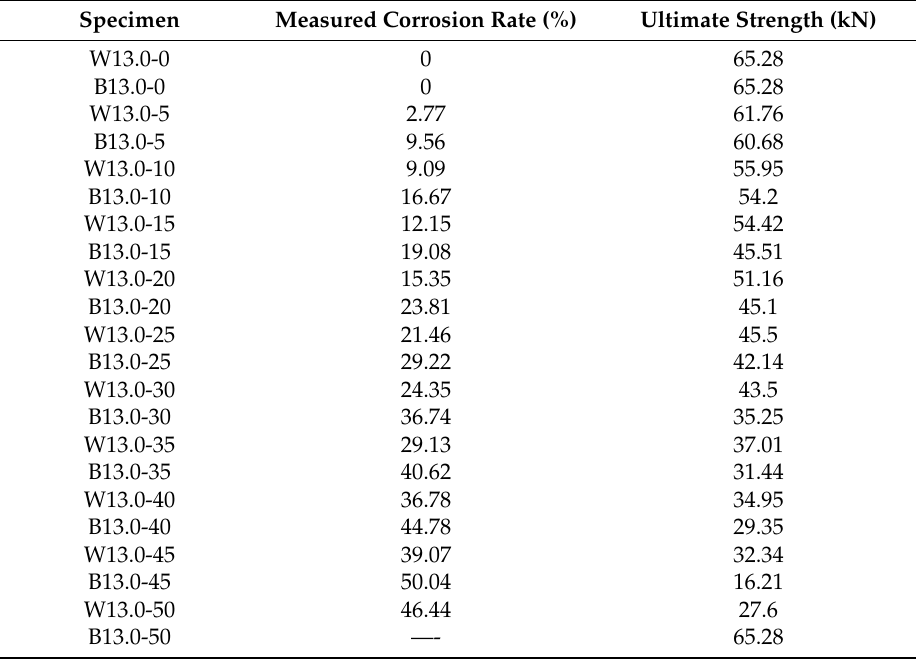
Table 6. Ultimate strengths of the 13.0 mm series single stud